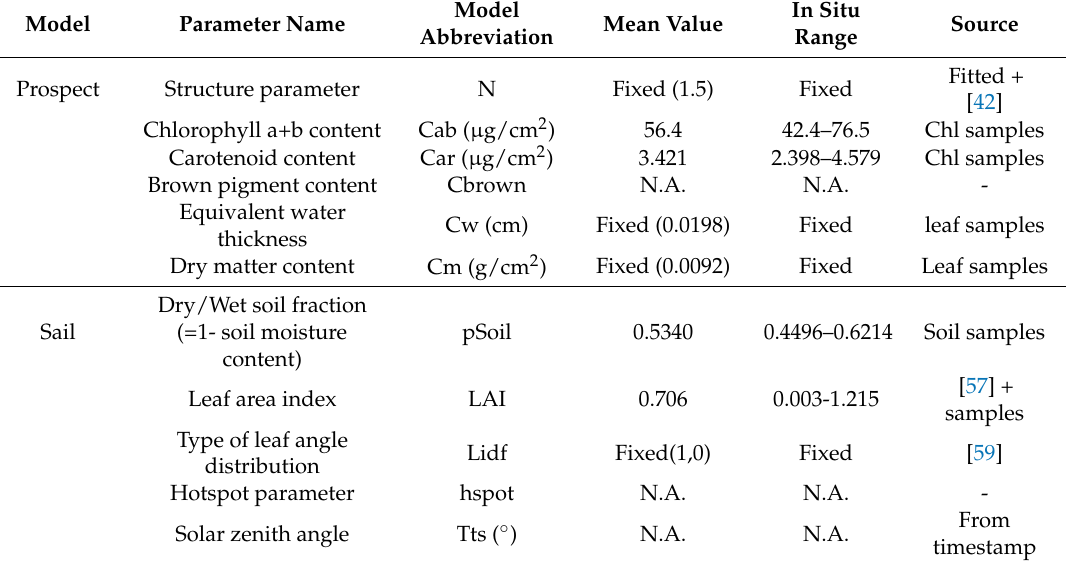
Table 1. ProSail model parameters. The parameter abbreviation is the abbreviation used in HSDAR for the model parameter. The mean value is the average value of the in situ measurements, fixed means it is not derived from in situ measurements. The in situ range describes the range of values (minimum-maximum) that occurred, and were used to simulate their effect on